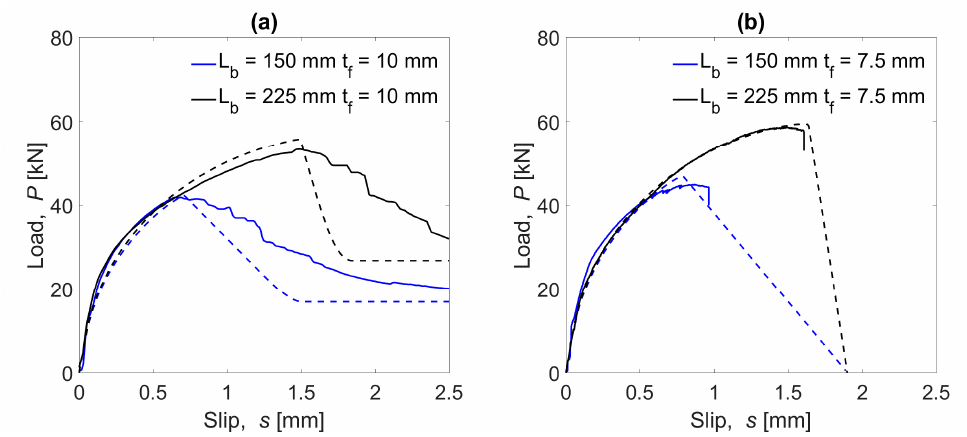
Figure 13. Comparison between the experimental (continuous lines) and the theoretical (dashed lines) values for the NSM with (a) 10 mm and (b) 7.5 mm groove thickness.